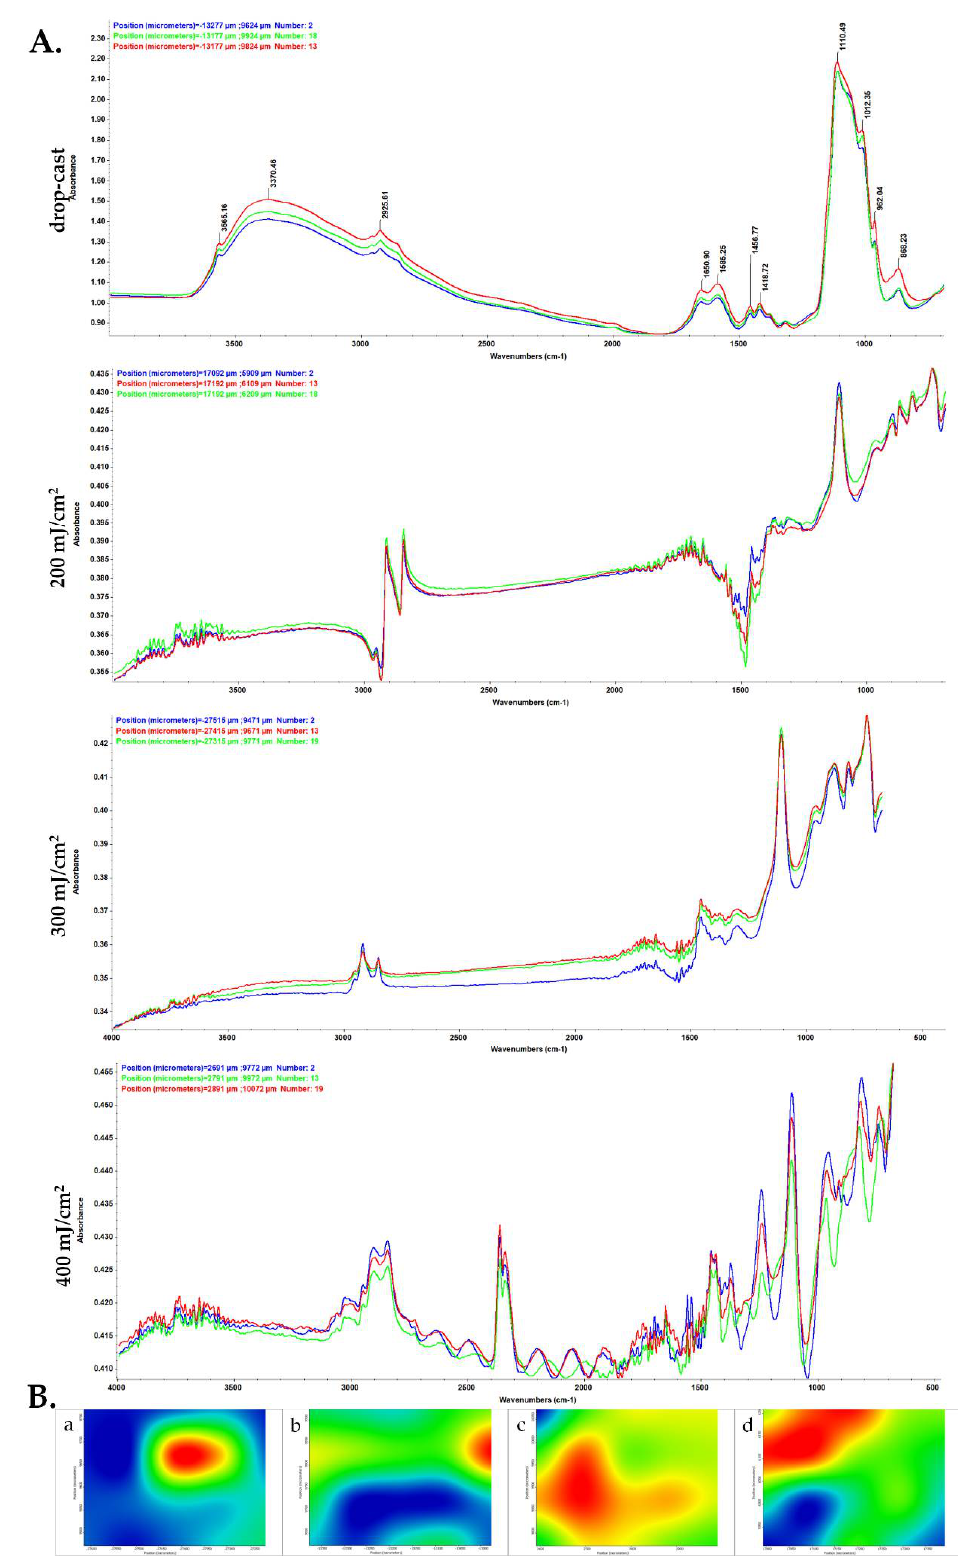
Figure 3. IR micrographs ( B ) and corresponding IR spectra ( A ) of HAp/CS/FGF2 coatings at ( b ) 200, ( c ) 300 and ( d ) 400 mJ/cm 2 laser fluences and ( a )